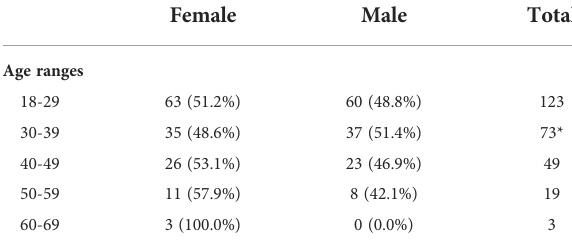
TABLE 1 Age ranges and sex for retrospective study subjects.